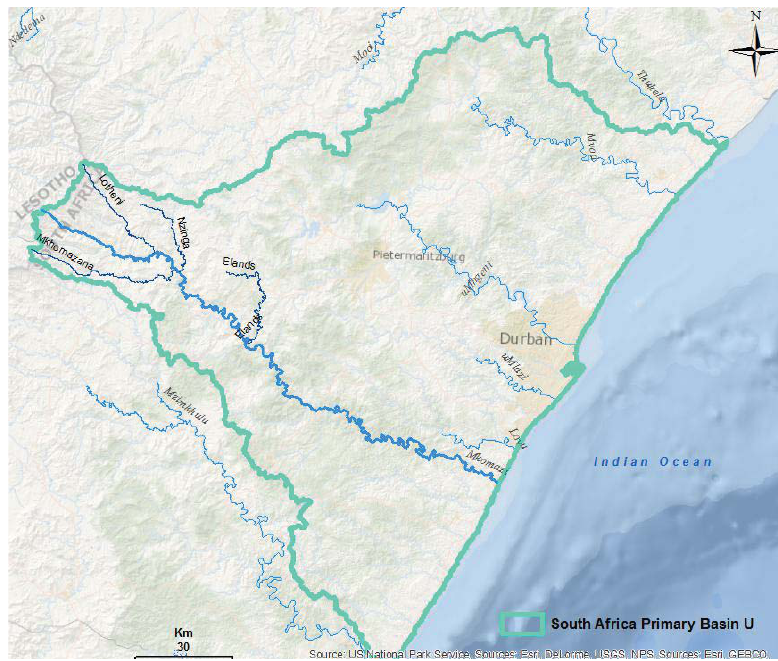
Fig. 3. Mkomazi River inside the primary basin U.